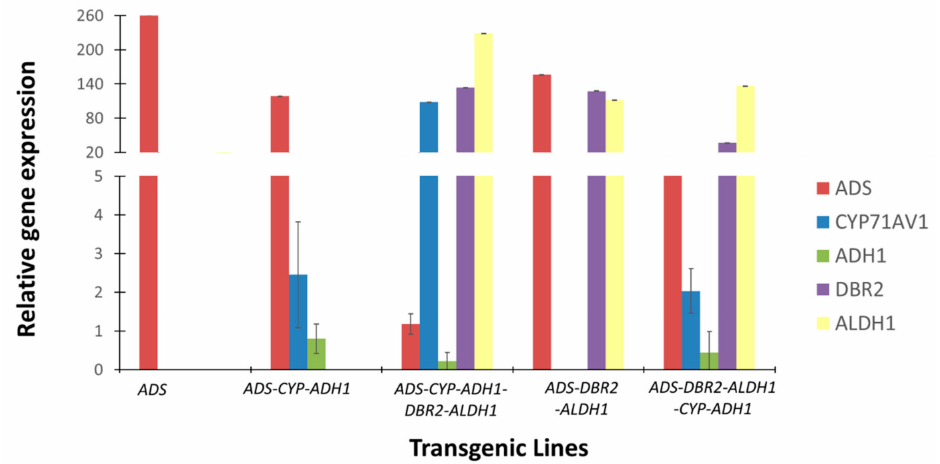
Figure 2. Relative expression of artemisinin pathway genes ( ADS, CYP71AV1, ADH1, DBR2, ALDH1 ) in the five transgenic P. patens lines. Error bars are shown as SE (n =